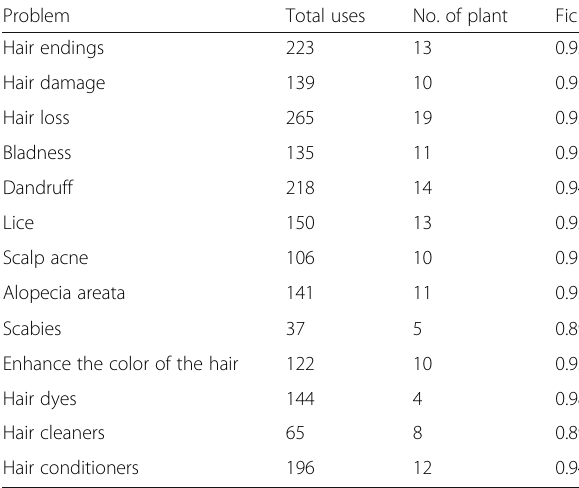
Table 4 Factor of informant ’ s consensus (F ic ) for herbals, categorized by the types of cosmeceutical